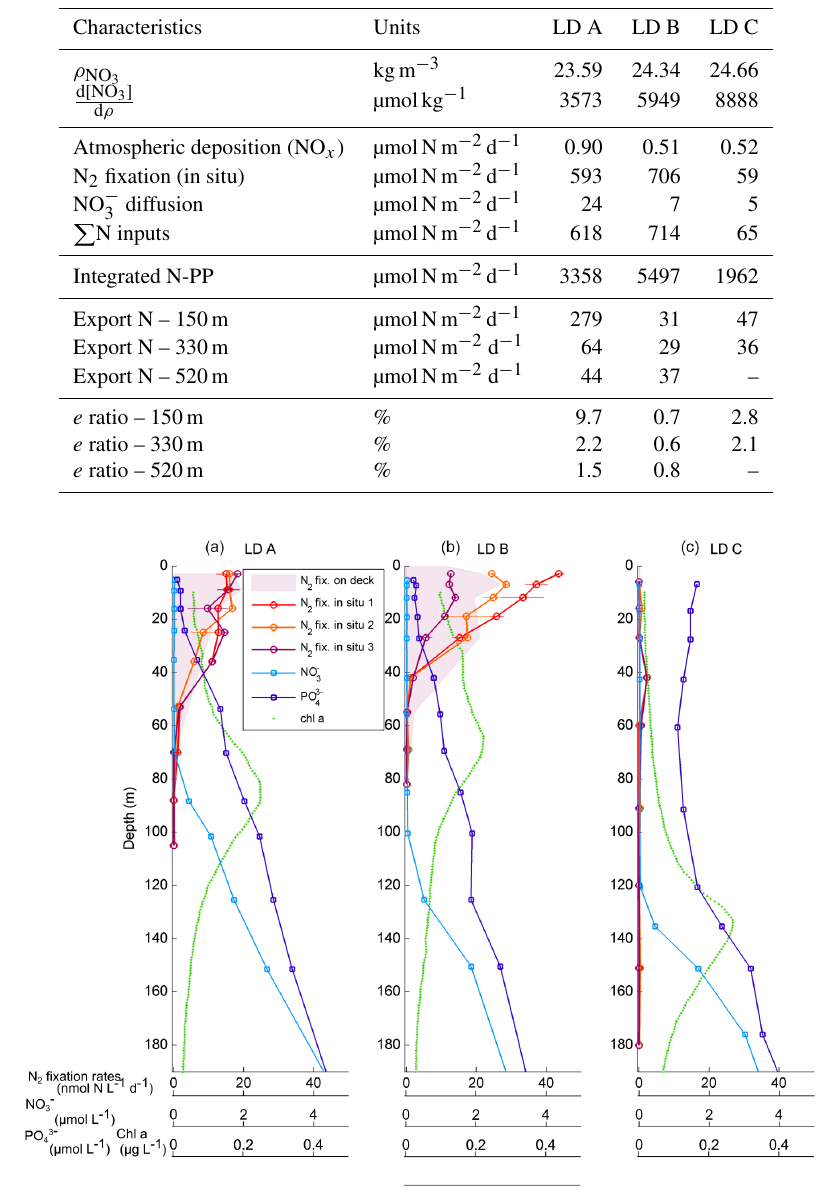
Figure 2. Vertical profiles of net N 2 fixation rates (nmolNL − 1 d − 1 ) estimated using in situ incubations at day 1 (in situ 1: red circles), day 3 (in situ 2: orange circles) and day 5 (in situ 3: purple) and using on-deck incubations (purple filled area) at stations LD A (a) , LD B (b) and LD C (c) . The NO − concentrations averaged over the 5 days of station occupation are also reported (light blue squares: µmolL − 1 ) , as well 3 as PO 3 − concentrations (dark blue squares: µmolL − 1 ) , and fluorescence/chlorophyll (green dots: µgL − 1 ) . 4 values correspond to the top of the nitracline; the isopycnal ρ = ρ NO (Fig. 3; Table 2). The corresponding d[NO 3 ] val- d ρ 3 ues were 3573, 5949 and 8888 µmol kg − 1 for stations LD A, LD B and LD C,